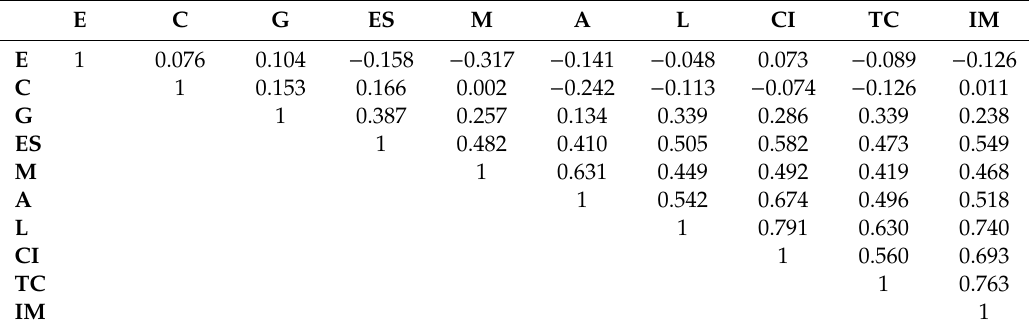
Table 7. Correlation between information use and access tools.